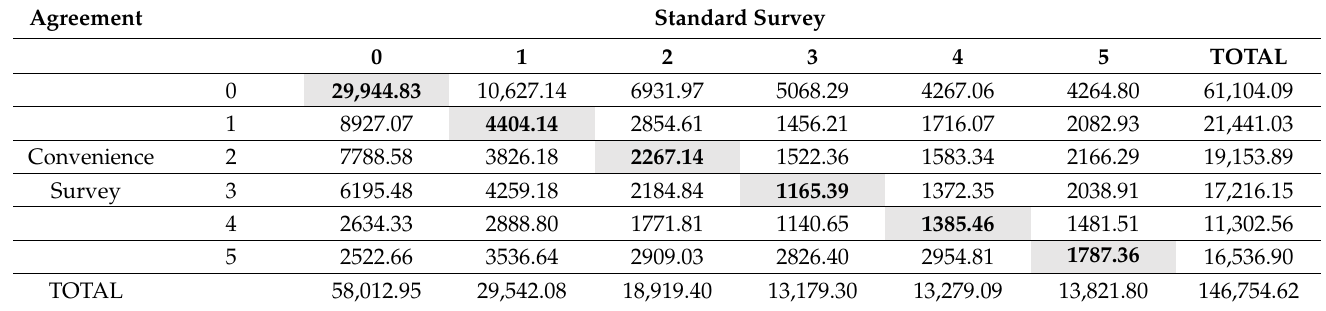
Table 4. I. scapularis SDM agreement between standard and convenience samples measured in sq km. Bold cells are regions where the numbers of SDMs for standard and convenience samples were in agreement. Off main diagonal elements showed discordance in classification based on survey